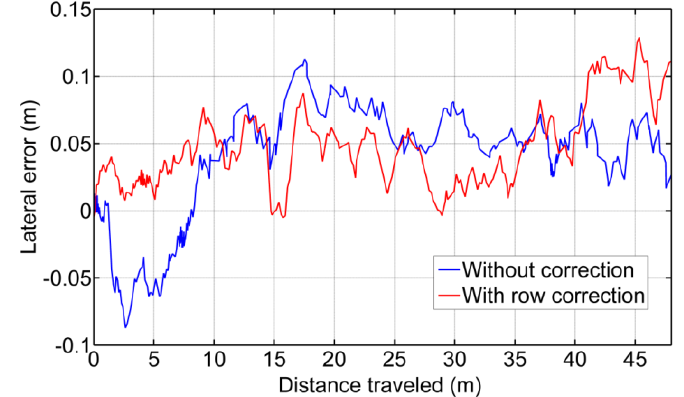
Figure 14. Comparison of the vehicle guidance in a maize field, represented as the lateral error of the rear axle with respect to the theoretical center of the